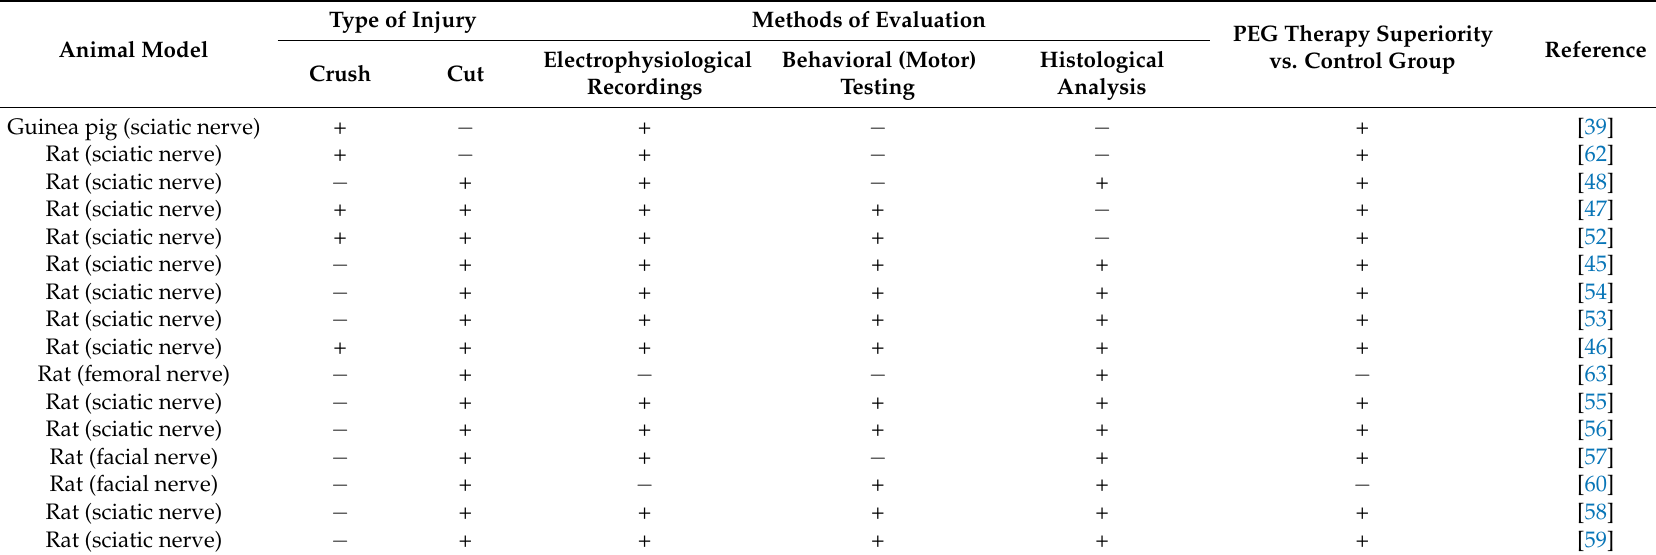
Table 1. Animal studies of polyethylene glycol therapy in the treatment of peripheral nerve injuries. + present, −